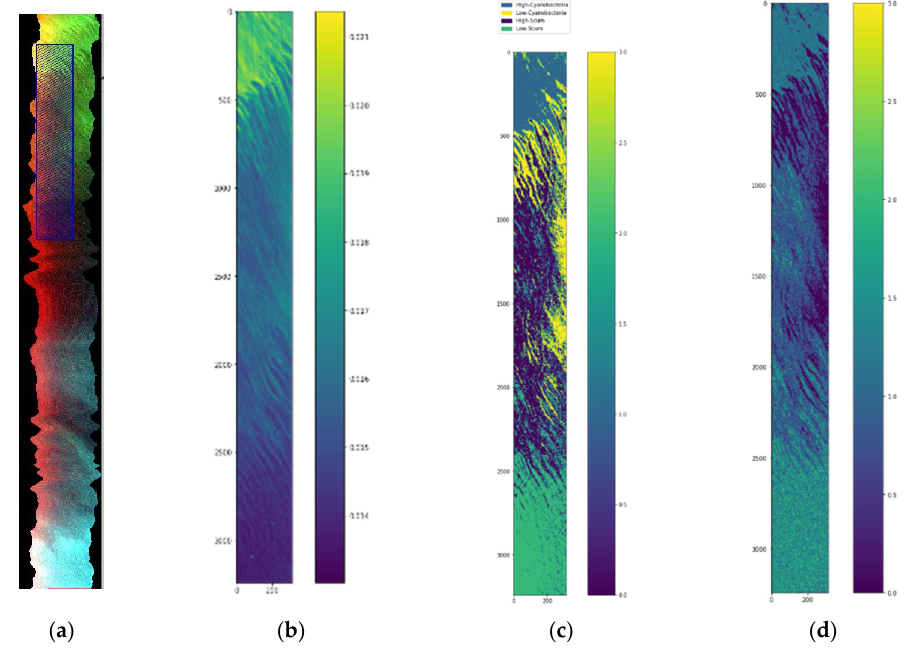
Figure 13. ( a ) Hyperspectral image of Lake Erie with extracted ROI shown as blue rectangle, ( b ) Zoomed ROI subimage, ( c ) Output image from unsupervised stage with four clusters, ( d ) Classified reconstructed image using 3 PCA bands and normalization scaling (Legends are the same as image in ( c )).